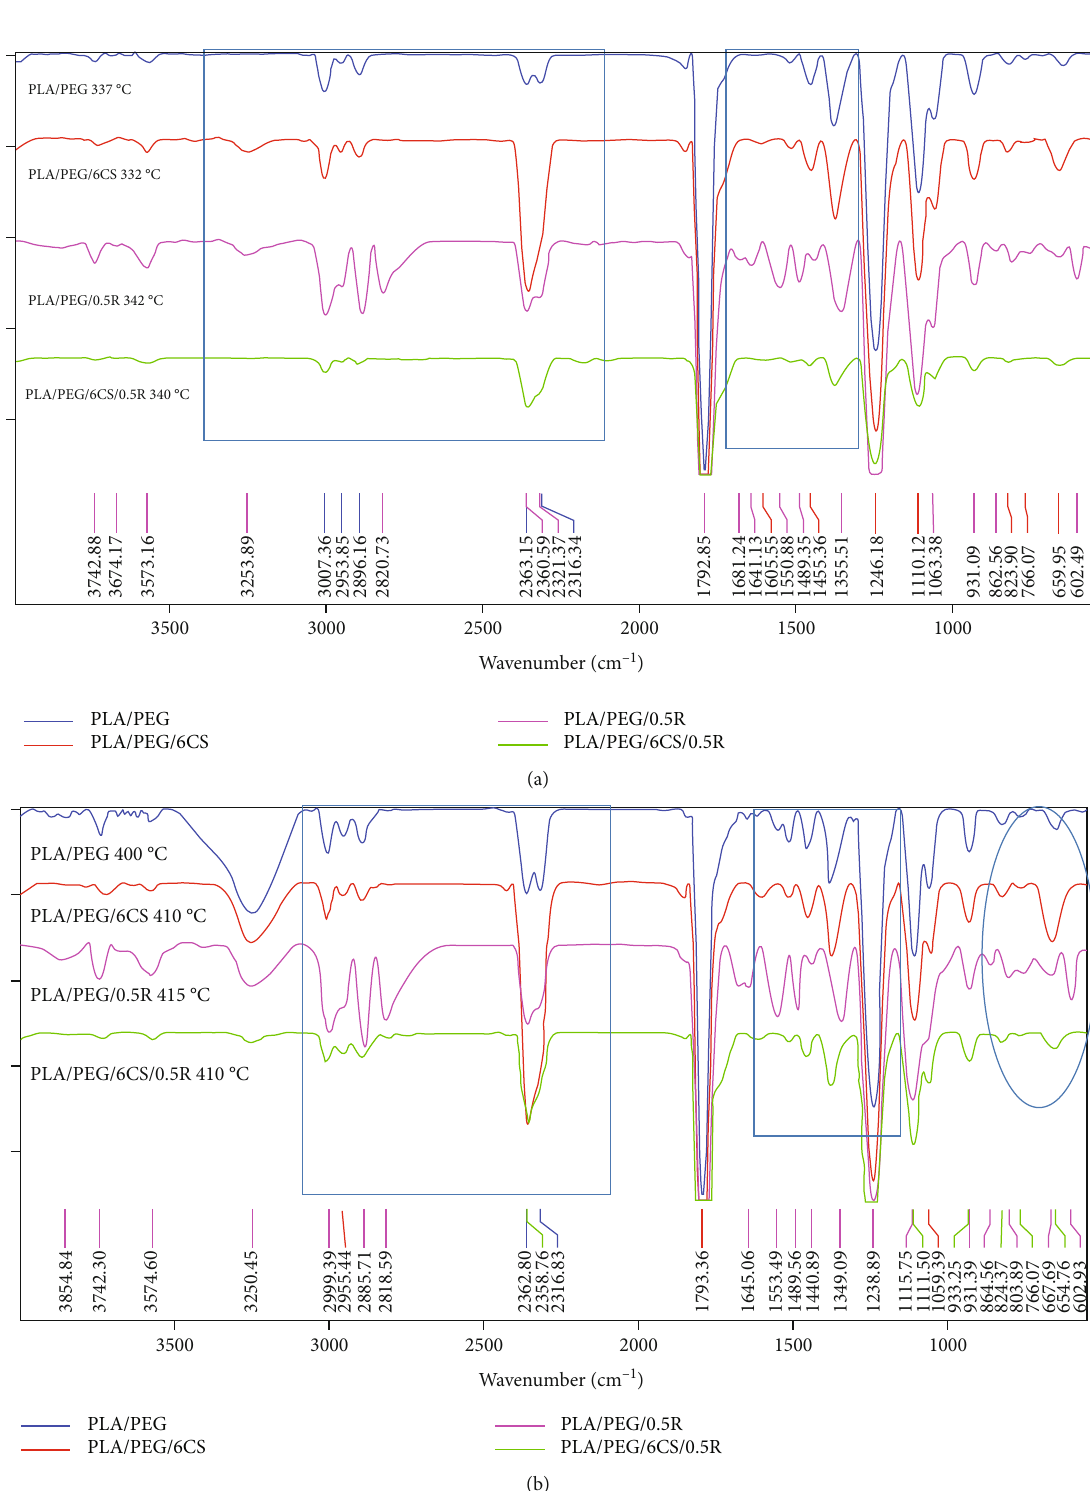
Figure 9: 2D FTIR spectra of the volatile decomposition products of PEG-plasticized PLA biocomposites at two GS temperatures of their evolution of ~ 330-340 ° C (a) and 410 ° C